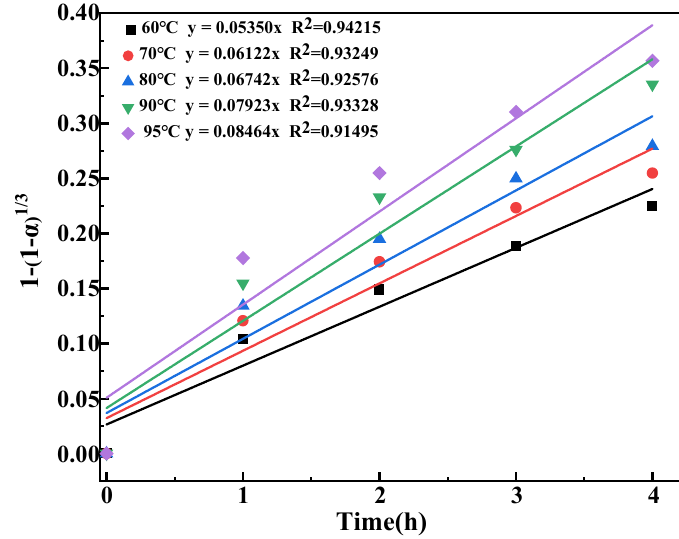
Figure 6. Plots of α versus time at different temperatures.